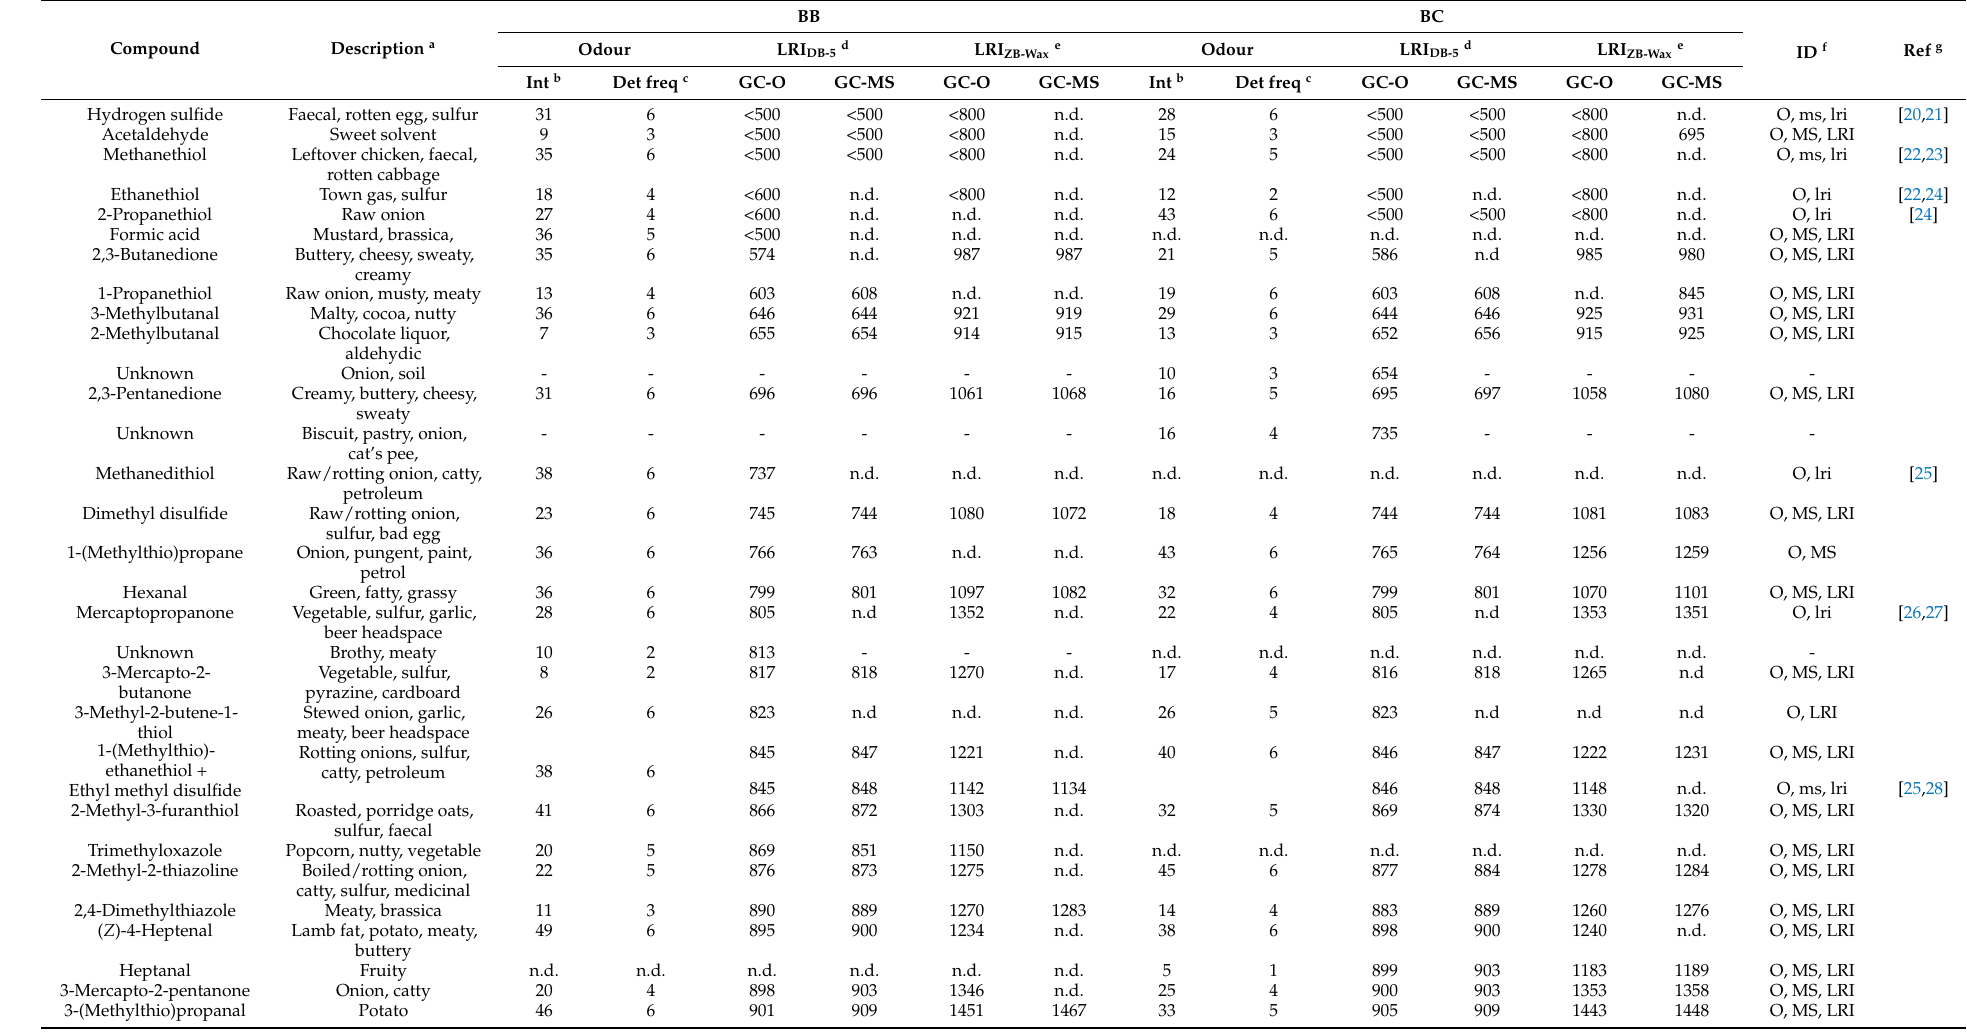
Table 1. Odour-active compounds in the boiled beef (BB) and boiled chicken (BC)